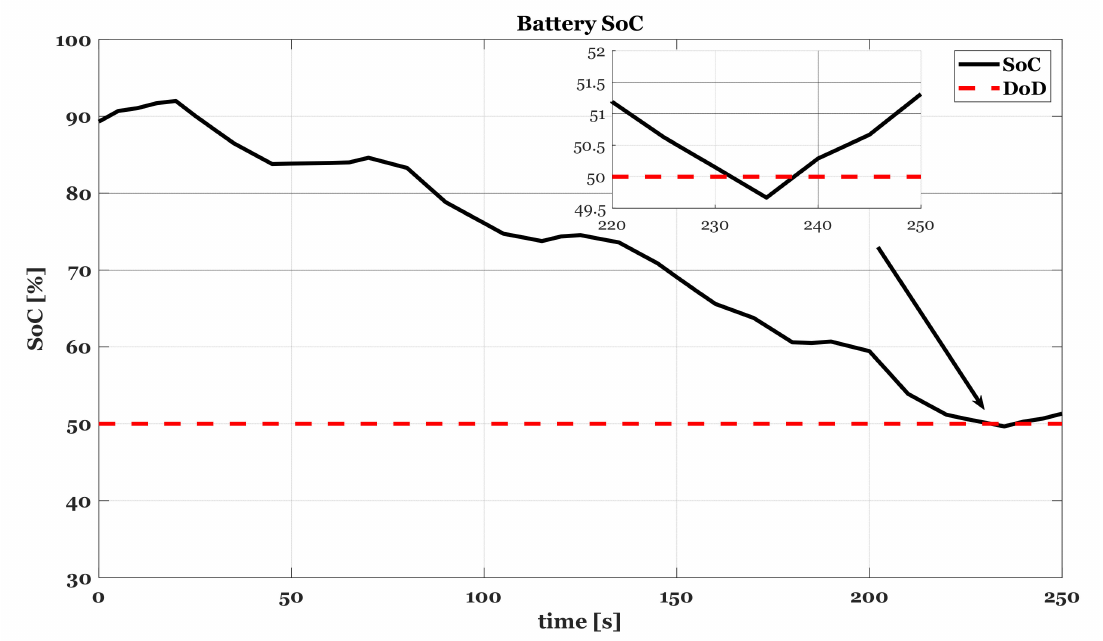
Figure 19. Battery SoC during the load cycle based on the standard sizing